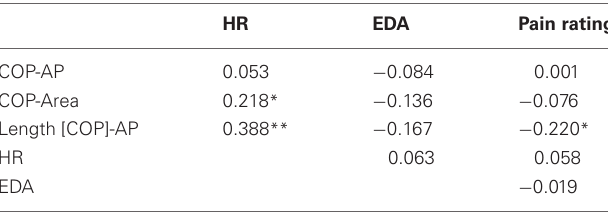
Table 2 | Correlation between postural data, physiological data, and pain